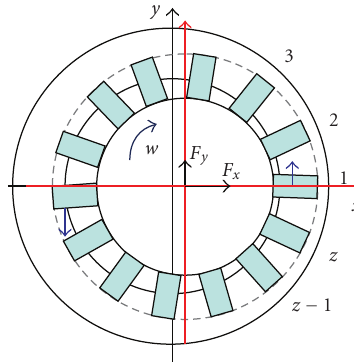
Figure 3: Meshing distance of coupling with misalignment in x -